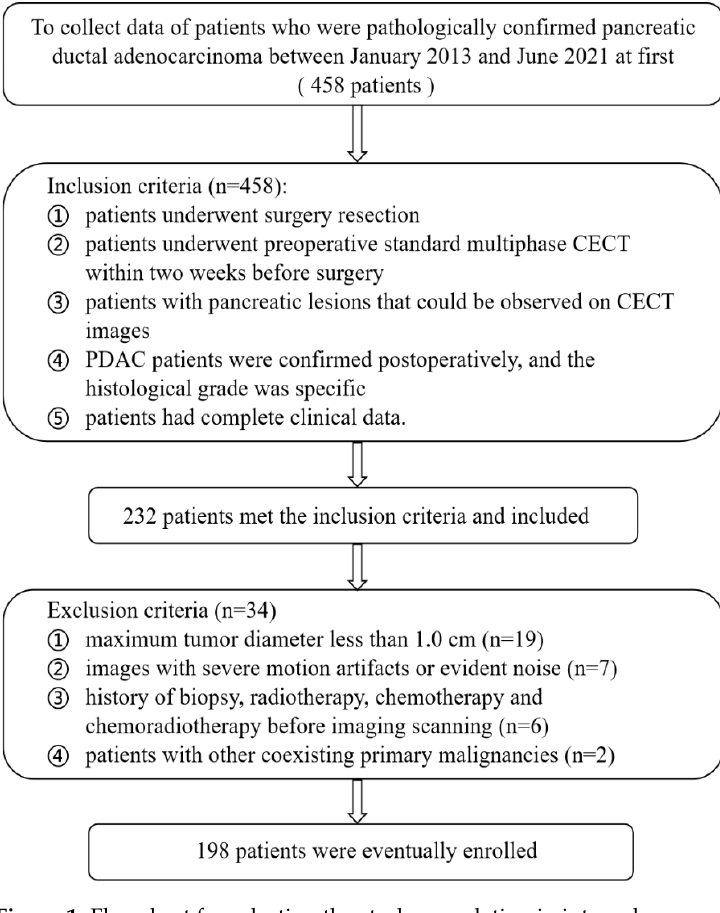
Figure 1. Flowchart for selecting the study population in internal group.